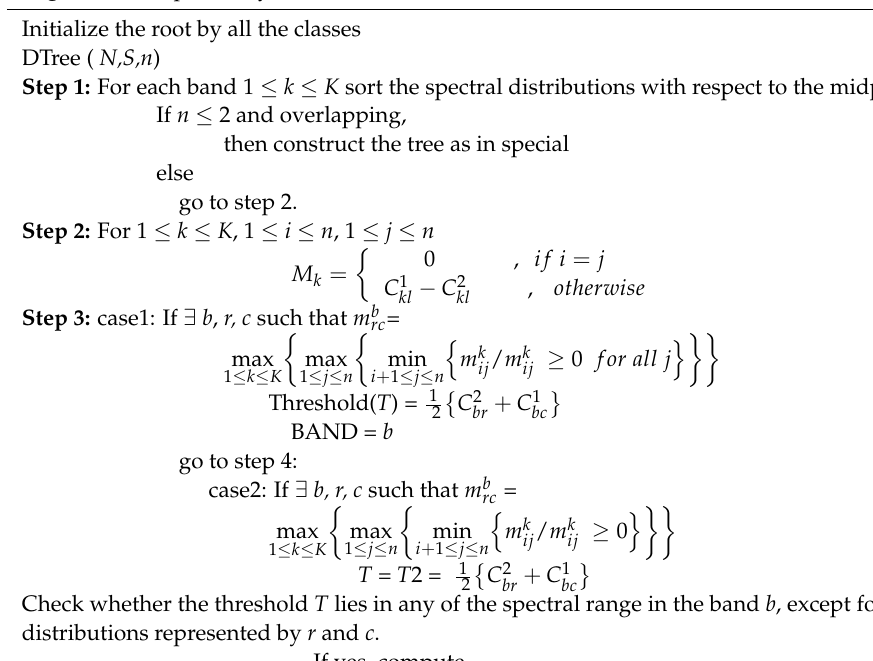
Algorithm 1 Separability-Matrix-Based Decision Tree